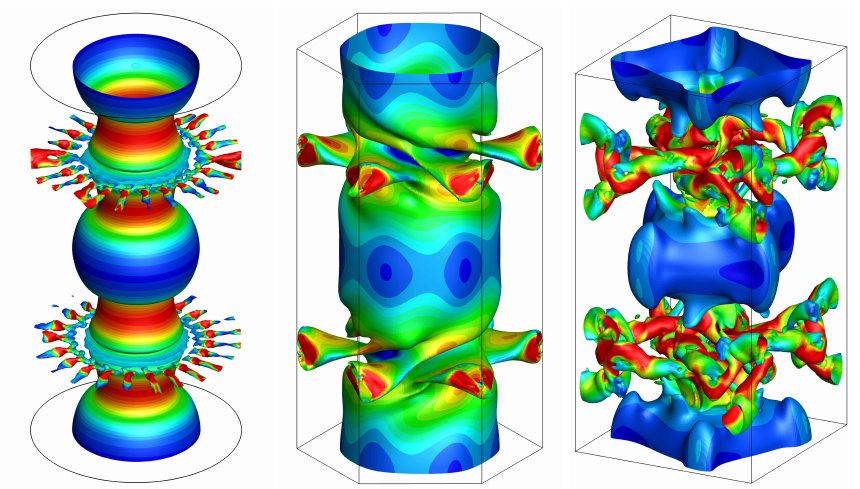
Figure 5. Snapshots of potential fields decorated by kinetic energy for three vortex filaments with circular, hexagonal, and square